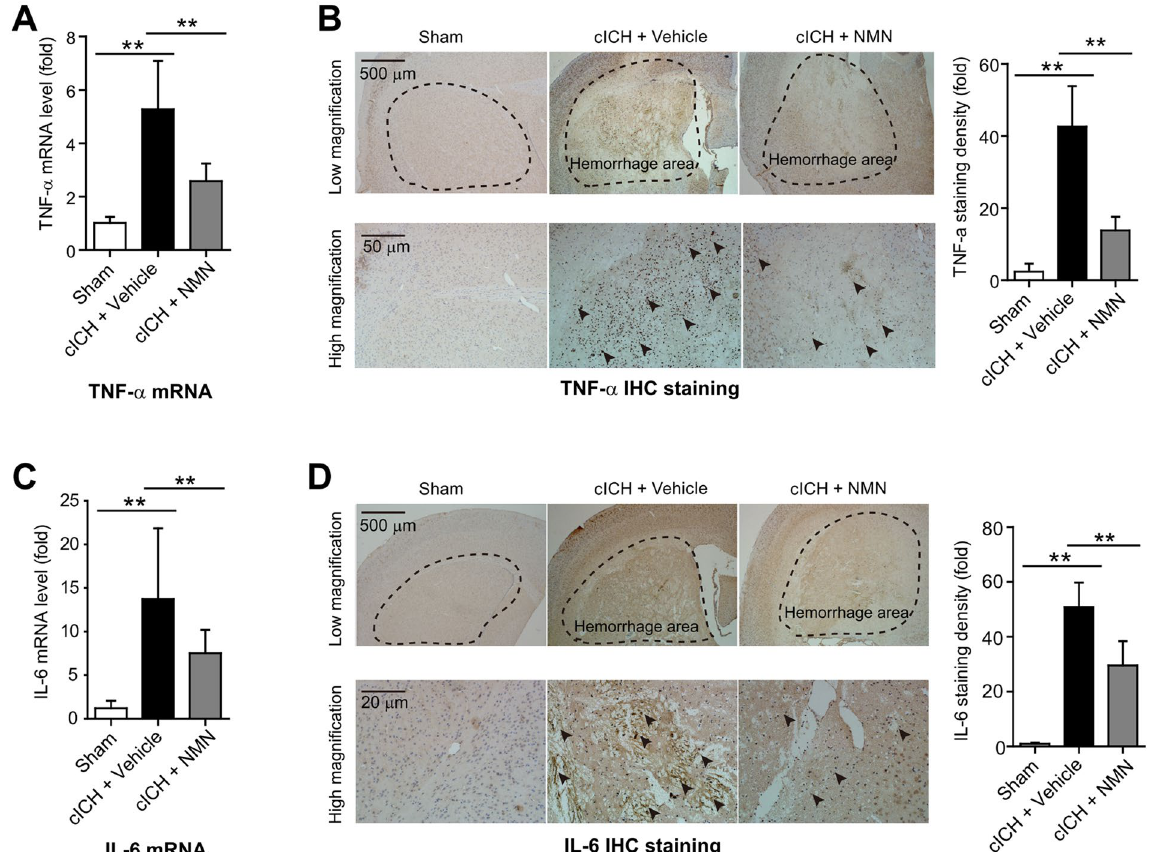
Figure 4. Effects of NMN on expression of TNF- α and IL-6 in mouse cICH model. ( A) The mRNA level of TNF- α in hemorrhagic brain tissue was evaluated at 24 hours post cICH by real-time PCR. ** P < 0.01. ( B ) The protein level of TNF- α in hemorrhagic brain tissue was evaluated at 24 hours post cICH by immunohistochemistry staining. ** P < 0.01. ( C ) The mRNA level of IL-6 in hemorrhagic brain tissue was evaluated at 24 hours post cICH by real-time PCR. ** P < 0.01. ( D ) The protein level of IL-6 in hemorrhagic brain tissue was evaluated at 24 hours post cICH by immunohistochemistry staining. ** P < 0.01. n = 3, 10 and 9 in Sham, cICH + Vehicle and cICH + NMN groups respectively for ( A–D